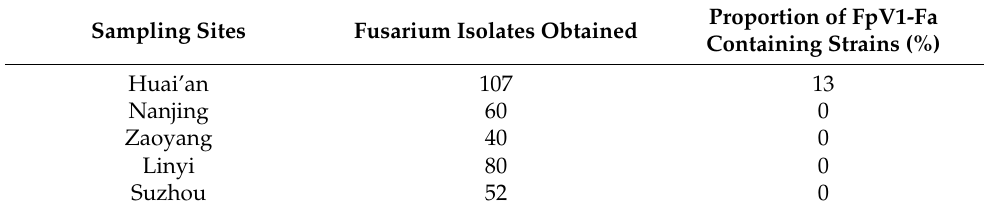
Table 1. Overview of Fusarium strains isolated during 2019 and